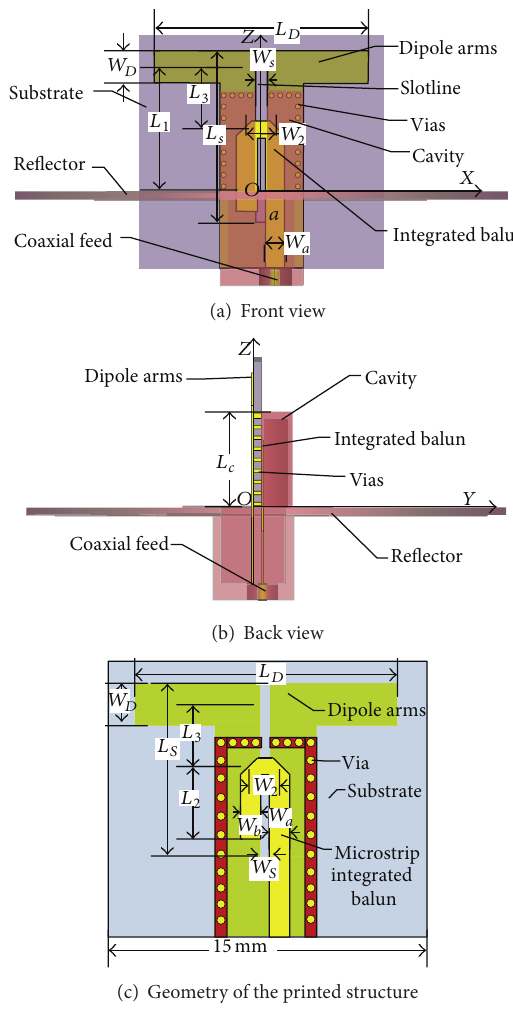
Figure 9: Antenna configuration.